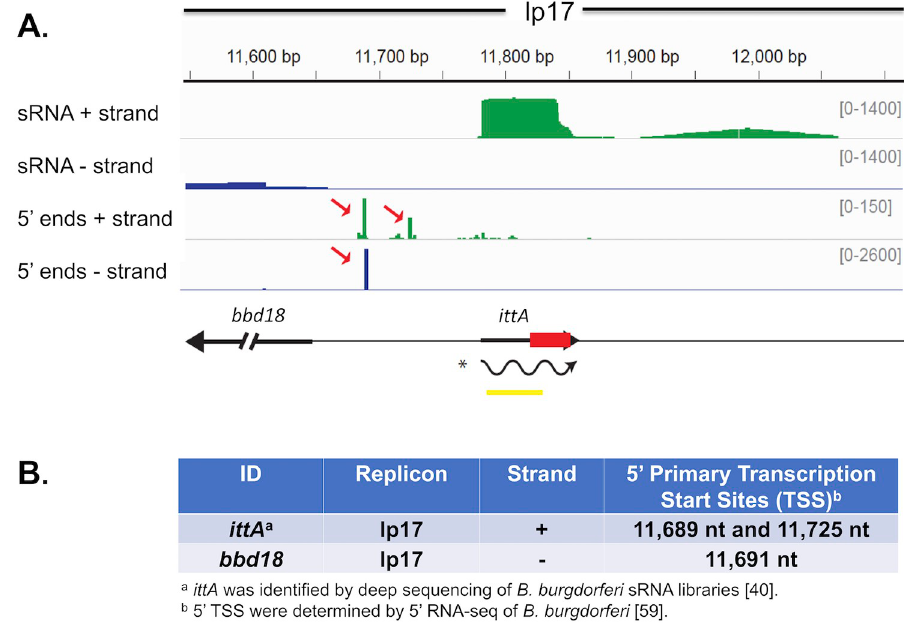
Fig 1. Location of SR0736/ ittA sRNA on linear plasmid 17 (lp17) and the identification of its primary 5’ transcriptional start sites (TSS). A. The deep sequencing results of the ittA sRNA are displayed in a coverage map. The negative strand coverage is shown in blue and the positive strand coverage in green. The genomic context is illustrated below the coverage maps: black arrows indicate the annotated ORFs, the yellow box indicates the Northern probe used, and the wavy line is the proposed mature sRNA species as determined by RNA-seq and Northern blot analysis. The red box represents the antibiotic resistance marker that is inserted into the ittA sRNA locus to obtain strain DM103. The sRNA is encoded in the positive strand and has two primary 5’ ends indicating transcriptional start sites (TSS) denoted by red arrows in the 5’ end + track. The sequencing results show the sRNA is processed into its mature form visualized as the “green box” in the sRNA + strand track. B. The primary 5’ TSS of ittA and gene bbd18 . The bbd18 gene is encoded on the negative strand and is located upstream of ittA in lp17. The ittA sRNA has two primary 5’ TSS; one of the TSS (nucleotide 11,689) overlaps with the bbd18 TSS (nucleotide 11,691) on the opposite strand, as observed in the 5’end—track. The sequencing results show the sRNA processed into its mature form.